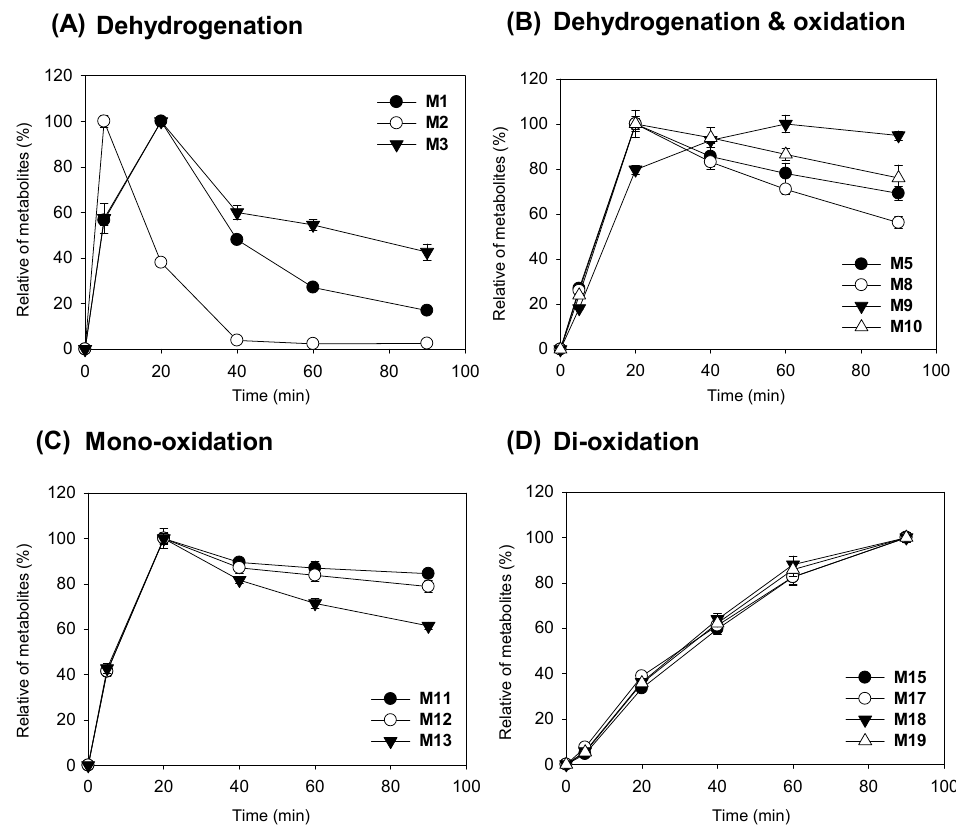
Figure 5. Time-dependent synthesis of anhydrocinnzeylanine (AHC) metabolites. Dehydrogenated metabolites ( M1 , M2 , and M3 ) ( A ), dehydrogenated and oxidated metabolites ( M5 , M8 , M9 , and M10 ) ( B ), mono-oxidated metabolites ( M11 , M12 , and M13 ) ( C ), and dioxidated metabolites ( M15 , M17 , M18 , and M19 ) ( D ) were incubated with human liver microsomes at 37 °C for 0–90 min in the presence of the β -NADPH-regenerating system. Bars indicate standard error ( n = 3).